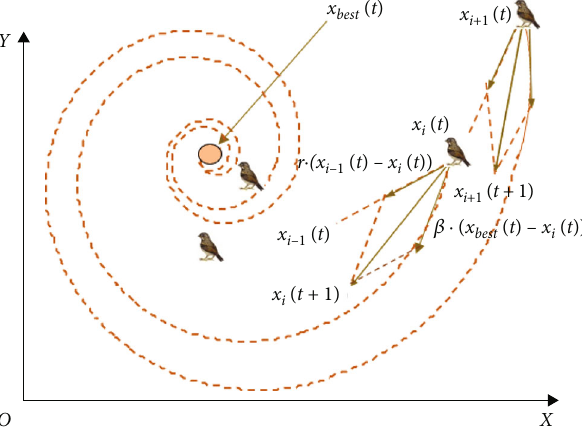
Figure 7: Cyclone foraging mechanism of individual